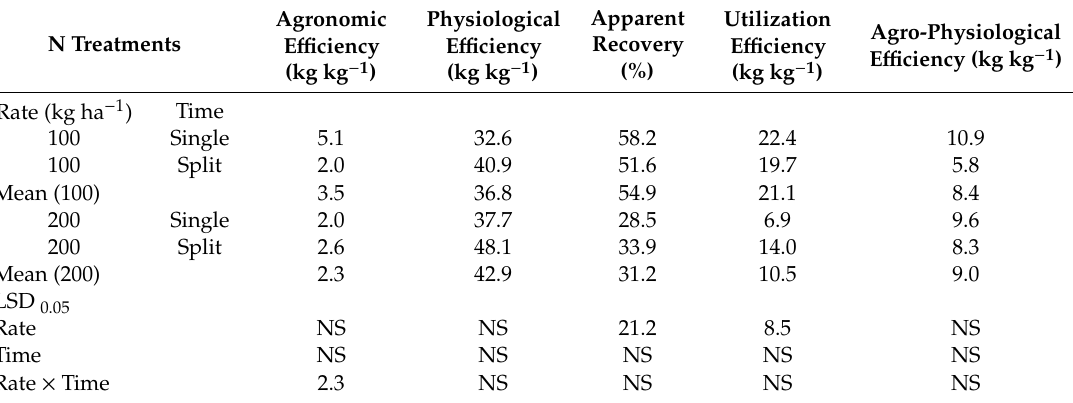
Table 9. E ff ect of di ff erent N applications on agronomic e ffi ciency, physiological e ffi ciency, apparent recovery, utilization e ffi ciency and agro-physiological e ffi ciency of rainfed canola at Tarlee site (see definitions and equations in Section